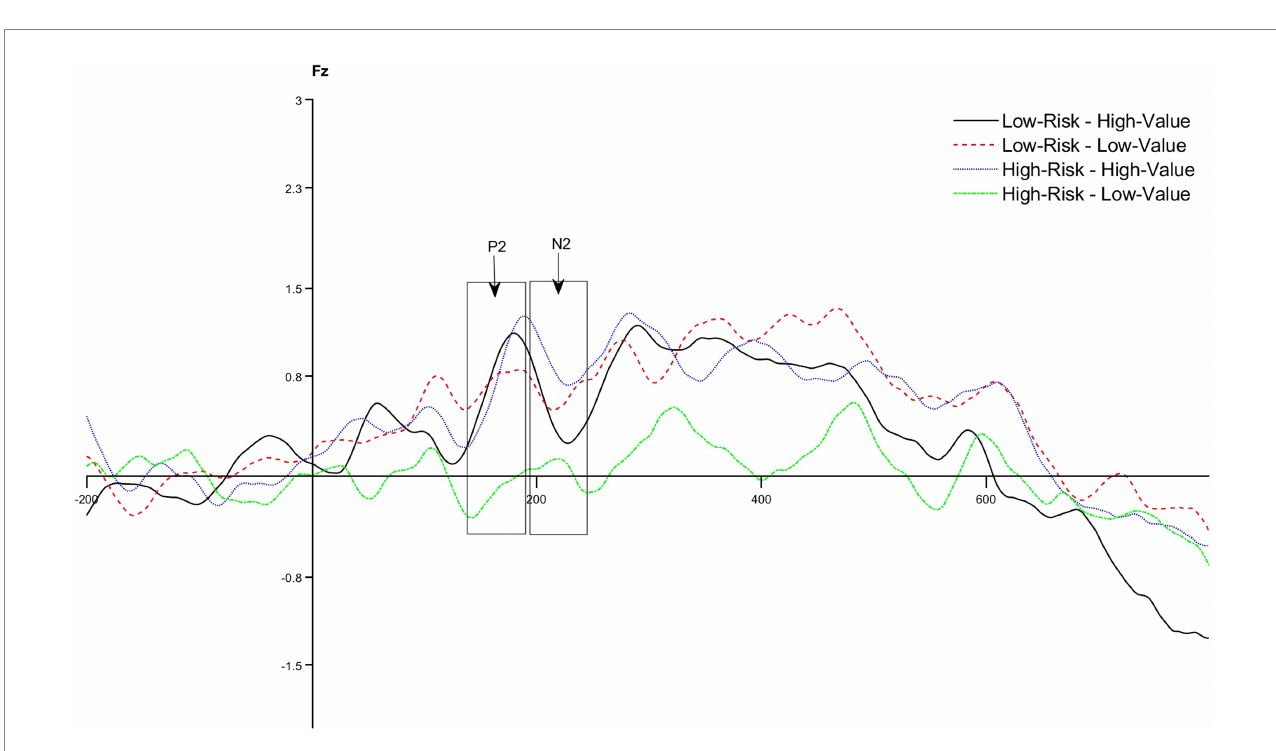
FIGURE 3 The amplitude of the P2 and N2 component.